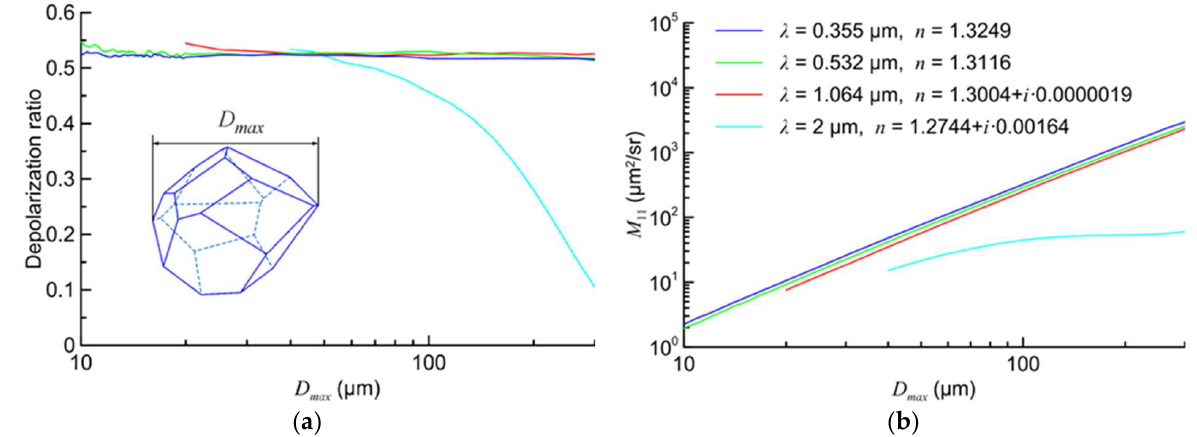
Figure 3. Depolarization ratio δ ( a ) and backscattering cross section M 11 ( b ) for arbitrary polyhedron at conventional lidar wavelengths.